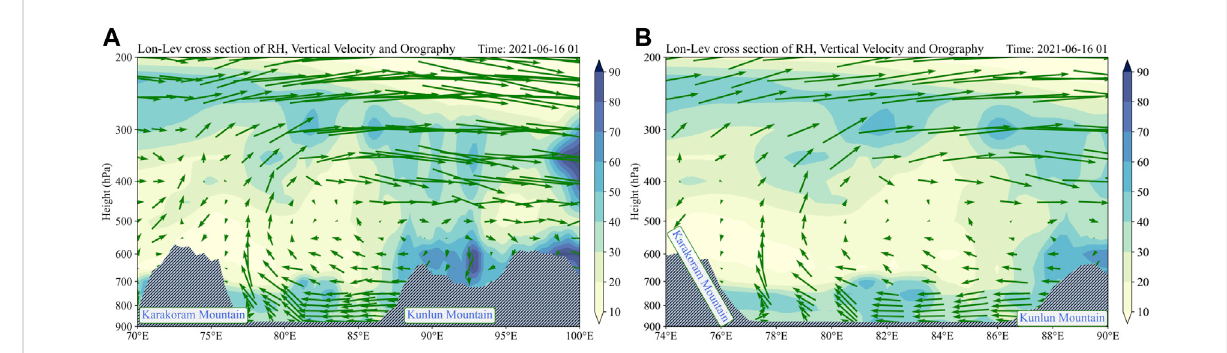
FIGURE 11 Height-longitude cross section of relative humidity (%) and wind vector between 900 hPa and 200 hPa around Hotan (37 ° N) at 01:00 16 June 2021. (A) (left) has larger longitude range than (B) (right) which mainly covers the heay rainfall